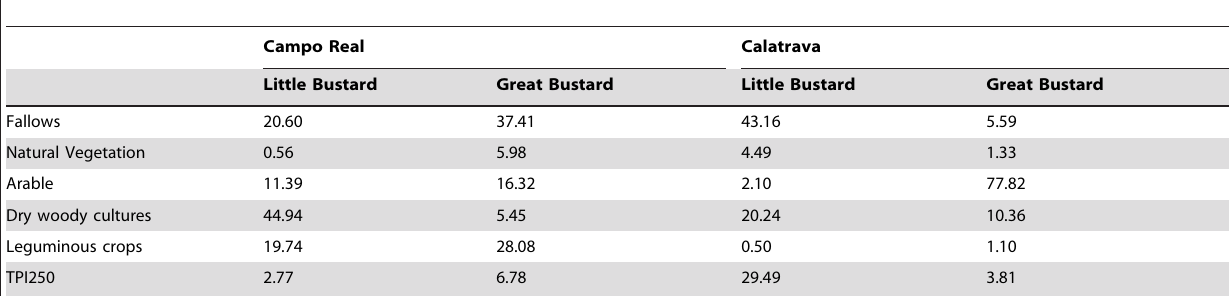
Table 2. Contribution percentages of each environmental predictor (percentage of each land use type, and Topographic position index at 250 m resolution) to each species and study site models yielded by